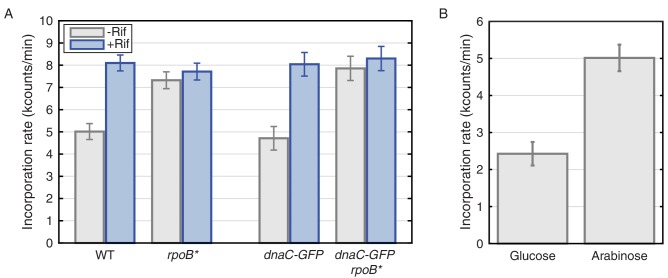
Thymidine incorporation assays determine the effect of transcription on replication rate.(A) DNA replication rates increase upon transcription-inhibition and in rpoB* strains. Thymidine incorporation assays were used to measure the relative rates of DNA replication in WT and DnaC-GFP strains, with (blue bars) and without (gray bars) perturbations to transcription by rifampicin treatment (Rif) or rpoB* cells. Note that rpoB* strains are resistant to rifampicin and therefore show no additional increase in replication rate after rifampicin treatment. (B) DNA replication rates increase in cells grown in minimal arabinose medium, relative to glucose, where transcription of rRNA and other ribosomal protein genes is higher.